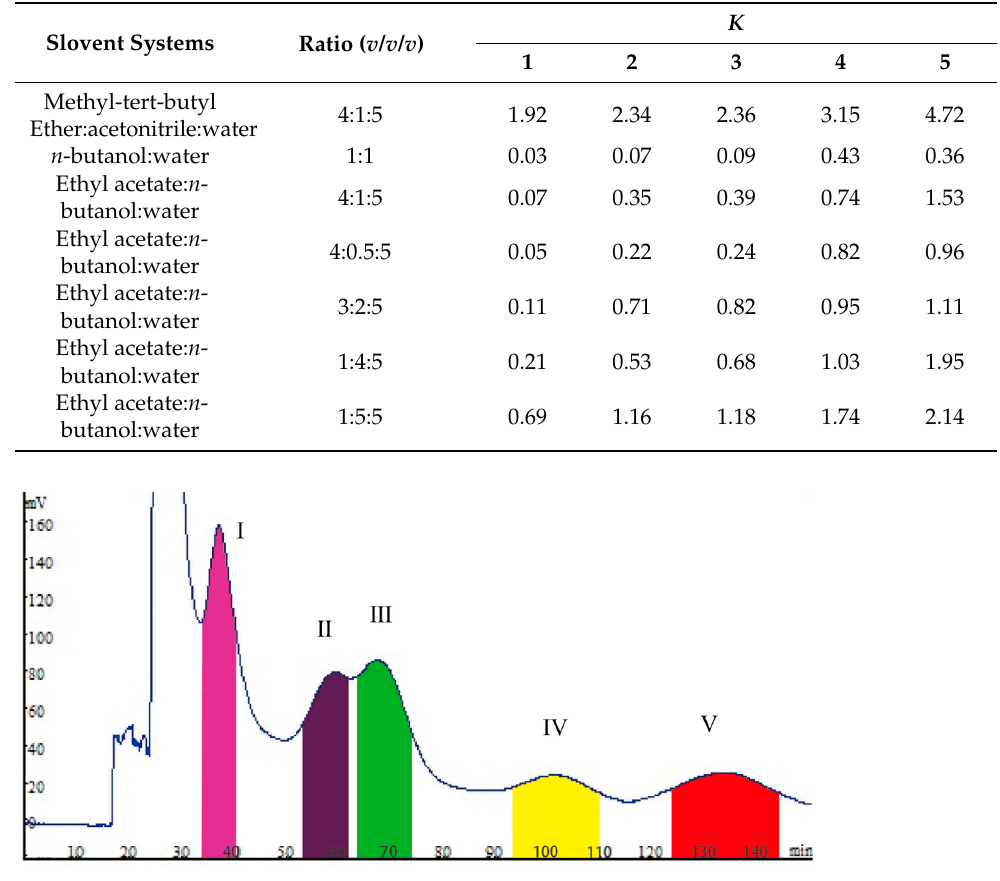
Table 1. The K values of target compounds in HSCCC separation with different solvent systems.